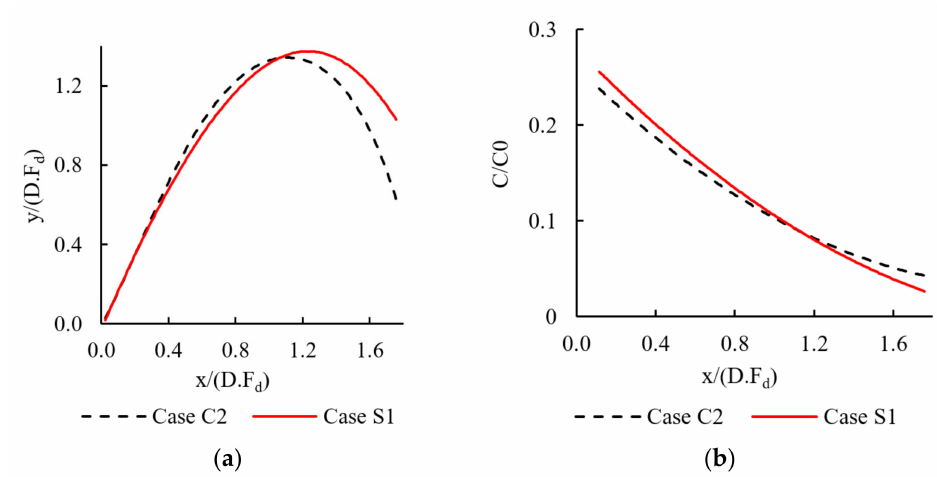
Figure 11. ( a ) Trajectory and ( b ) concentration of the central jet of cases C2 and S1.